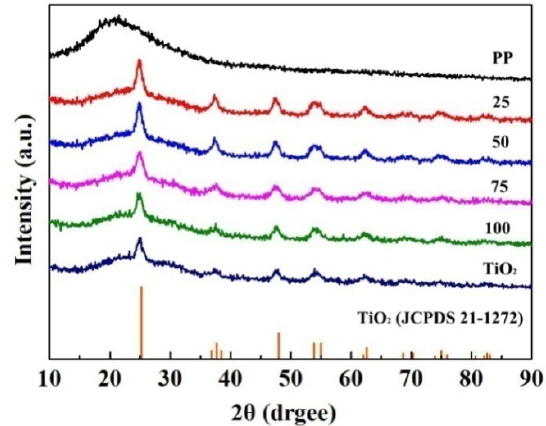
Figure 5. XRD spectra of PP, TiO 2 , and PP@TiO 2 nanospheres.